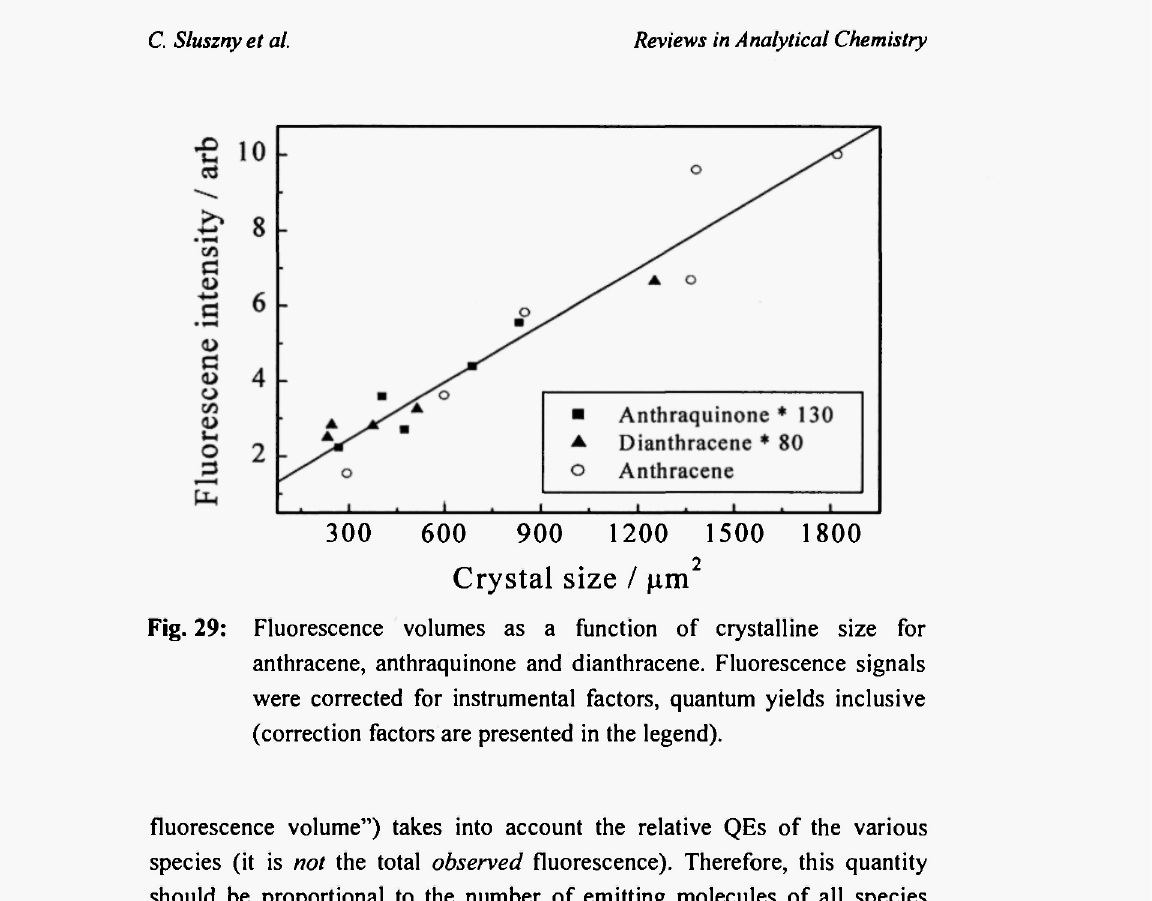
Fig. 29: Fluorescence volumes as a function of crystalline size for anthracene, anthraquinone and dianthracene. Fluorescence signals were corrected for instrumental factors, quantum yields inclusive (correction factors are presented in the